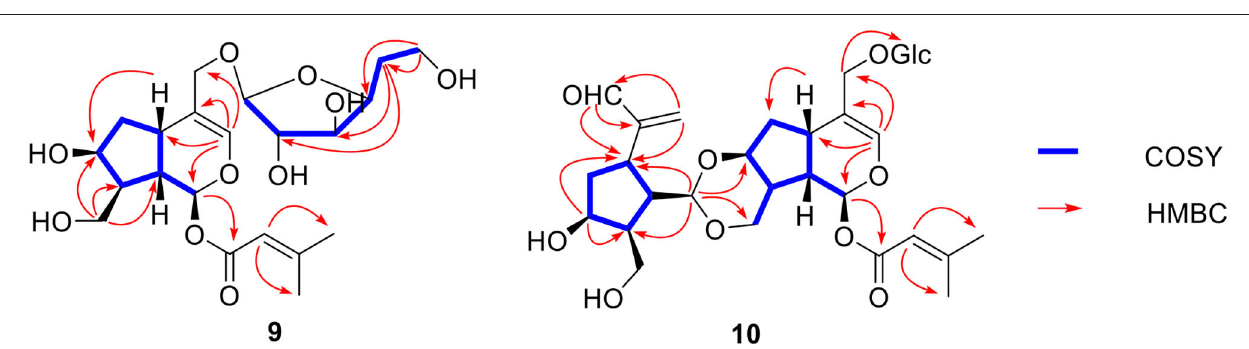
FIGURE 9 | Key 1 H- 1 H COSY and HMBC correlations of compounds